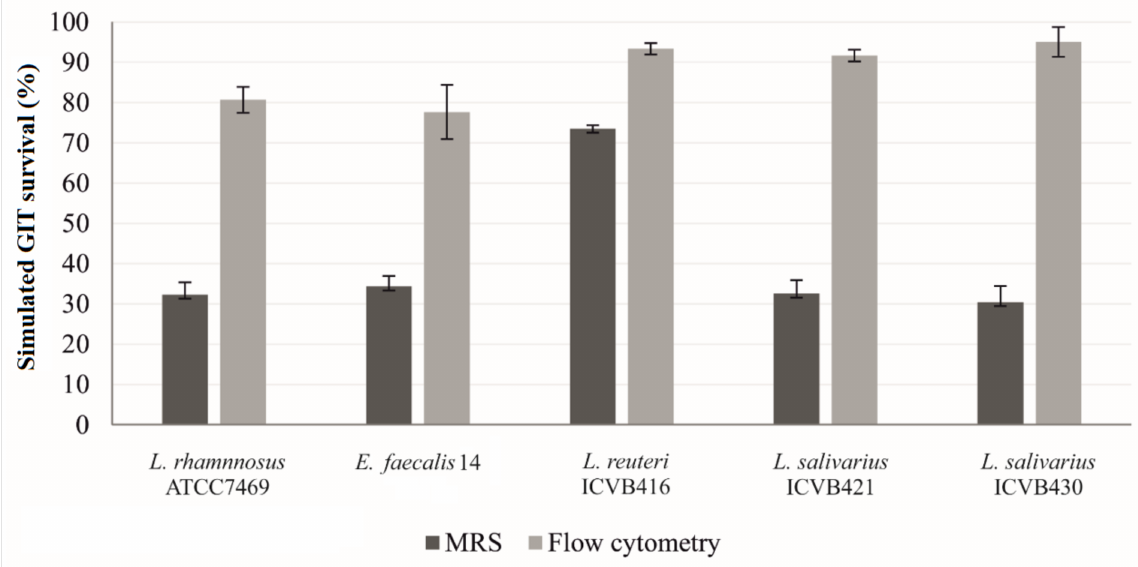
Figure 2. Survival rates of LAB strains under conditions mimicking chicken gastrointestinal environ- ment (%) using classical counting in MRS and flow cytometry. The cytometry assay was performed after labelling the cells with syto-24 and propidium